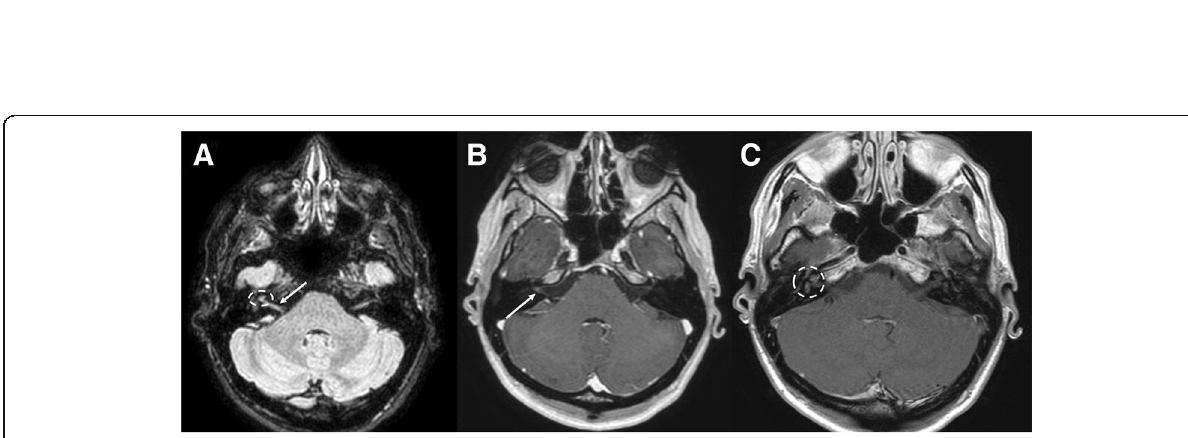
Fig. 27 Vestibular neuritis. MRI FLAIR ( a ) and T1-weighted post-gadolinium ( b , c ) axial images show mild hyperintensity ( a , arrow) and enhancement ( b , arrow) of the right vestibular nerve and right labyrinth ( a , c , dotted circles)